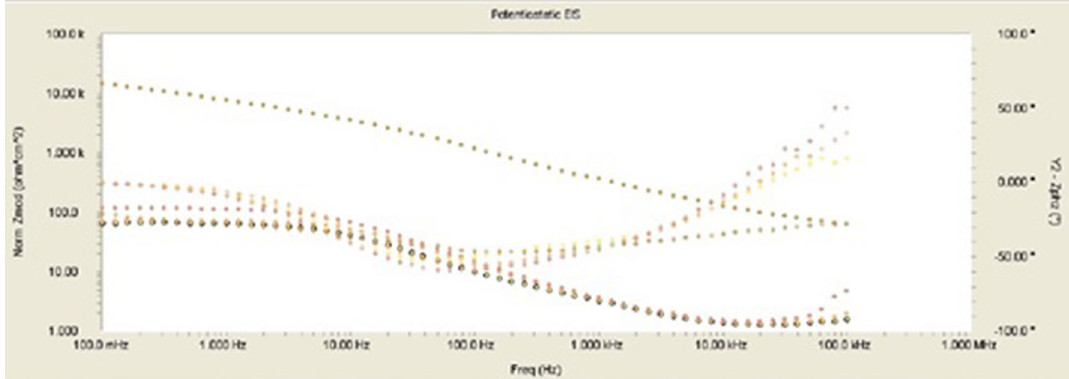
Figure 12. Experimental impedance and phase data in Bode format for MS in 1.0 M HCl containing 0.5 mM nonanedihydrazide denotes the fitted line using the equivalent